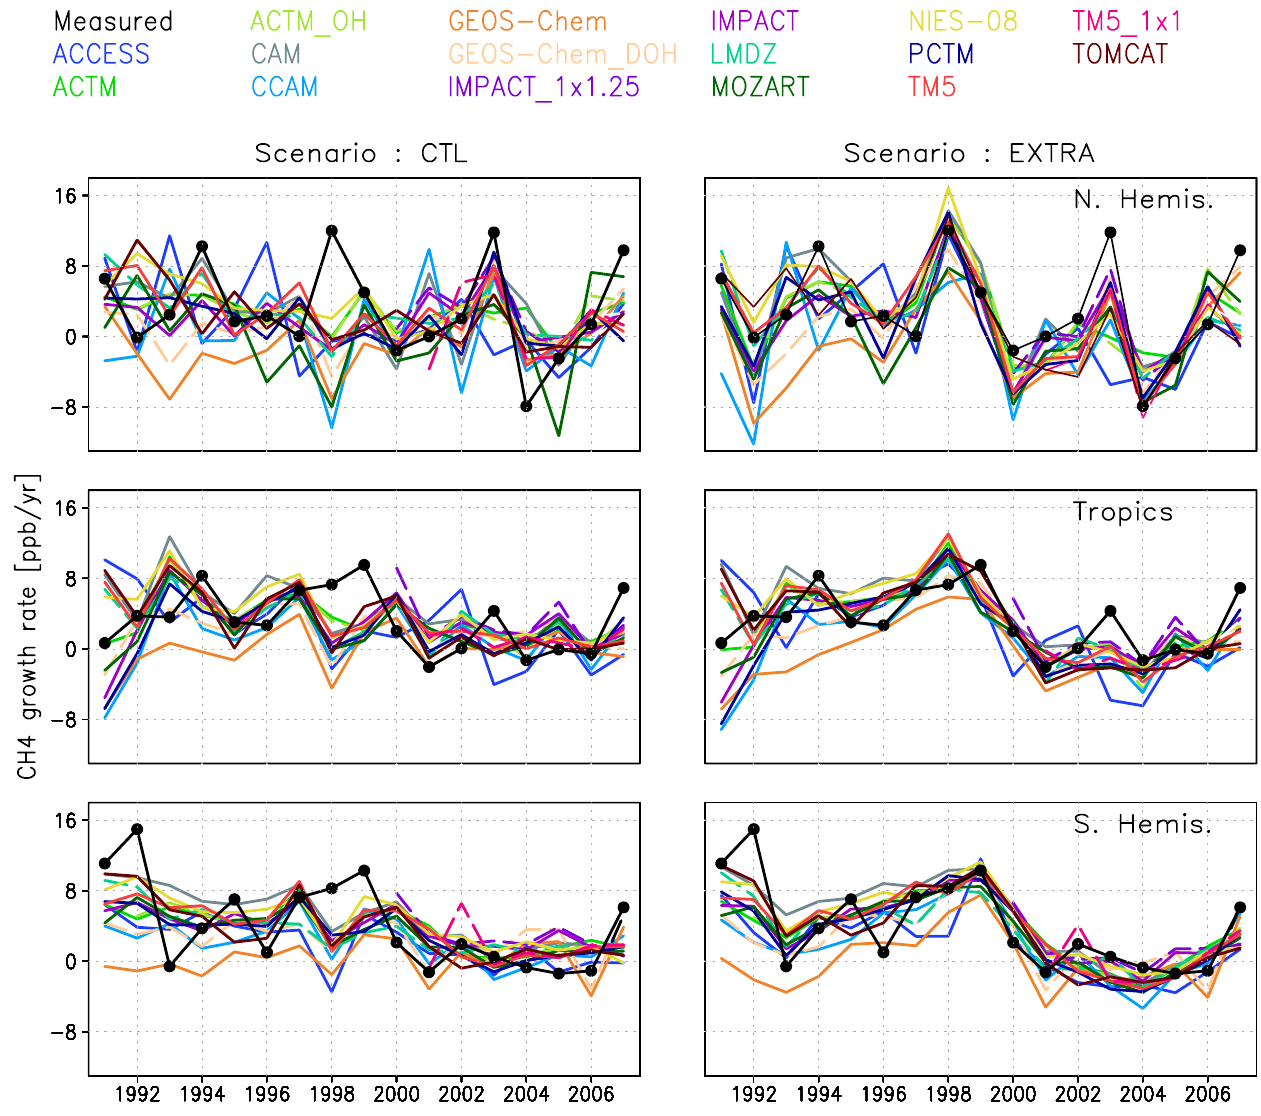
Fig. 6. Comparisons of observed and simulated annual mean growth rates of CH 4 in NH (top row; ALT, BRW and MHD average), tropics (middle row; MLO RPB and SMO average) and SH (bottom row; CGO and SPO average) for two selected fluxes, CTL (left column) and EXTRA (right column). Growth rate variabilities corresponding 4 other CH 4 scenarios are given in Figs. S20 and